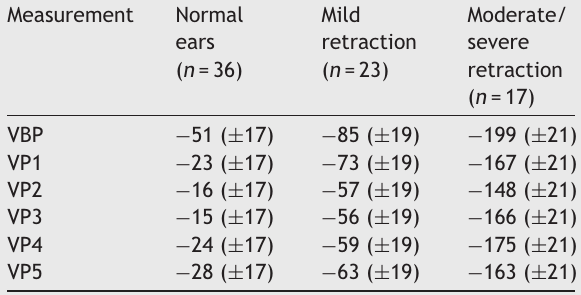
Estimated means obtained with a linear mixed model for the Valsalva maneuver in the three groups, at the first time point of assessment.